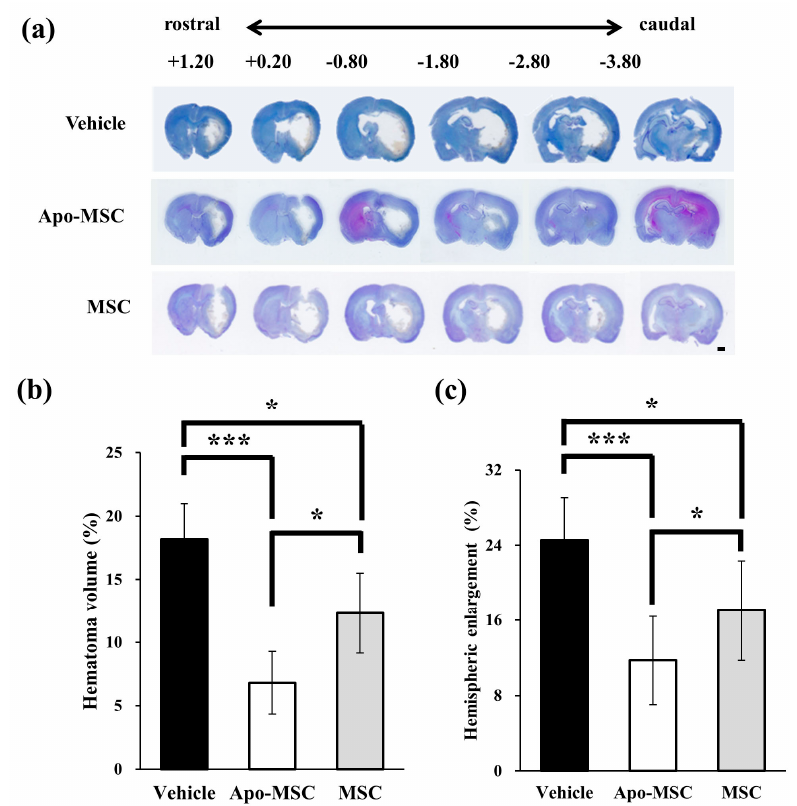
Figure 1. Effect of apocynin-preconditioned human placenta-derived mesenchymal stem cells (Apo-MSCs) and naïve mesenchymal stem cells (MSCs) on hematoma volume and brain edema in the rats at 48 h after the induction of an intracranial hemorrhage (ICH). ( a ) Representative images of cresyl violet staining, depicting the coronal whole-brain section at rostral-caudal levels from +2.04 to − 5.52 from the bregma. Unstained area inside brain parenchyma represents hematoma lesion. Scale bar = 1 mm. ( b ) The bar graphs represent the hematoma volume of the Apo-MSCs, naïve MSCs and vehicle treated groups at 48 h after ICH induction. The volume of hematoma is expressed as the proportion of total brain area (%). ( c ) The bar graphs represent hemispheric enlargement of the Apo-MSCs, naïve MSCs and vehicle treated groups at 48 h after ICH induction. The hemispheric enlargement is expressed as the percentage of increase in hemispheric size comparing with that of the contralateral hemisphere. Data are mean + standard deviation (SD). * p < 0.05, *** p < 0.001.